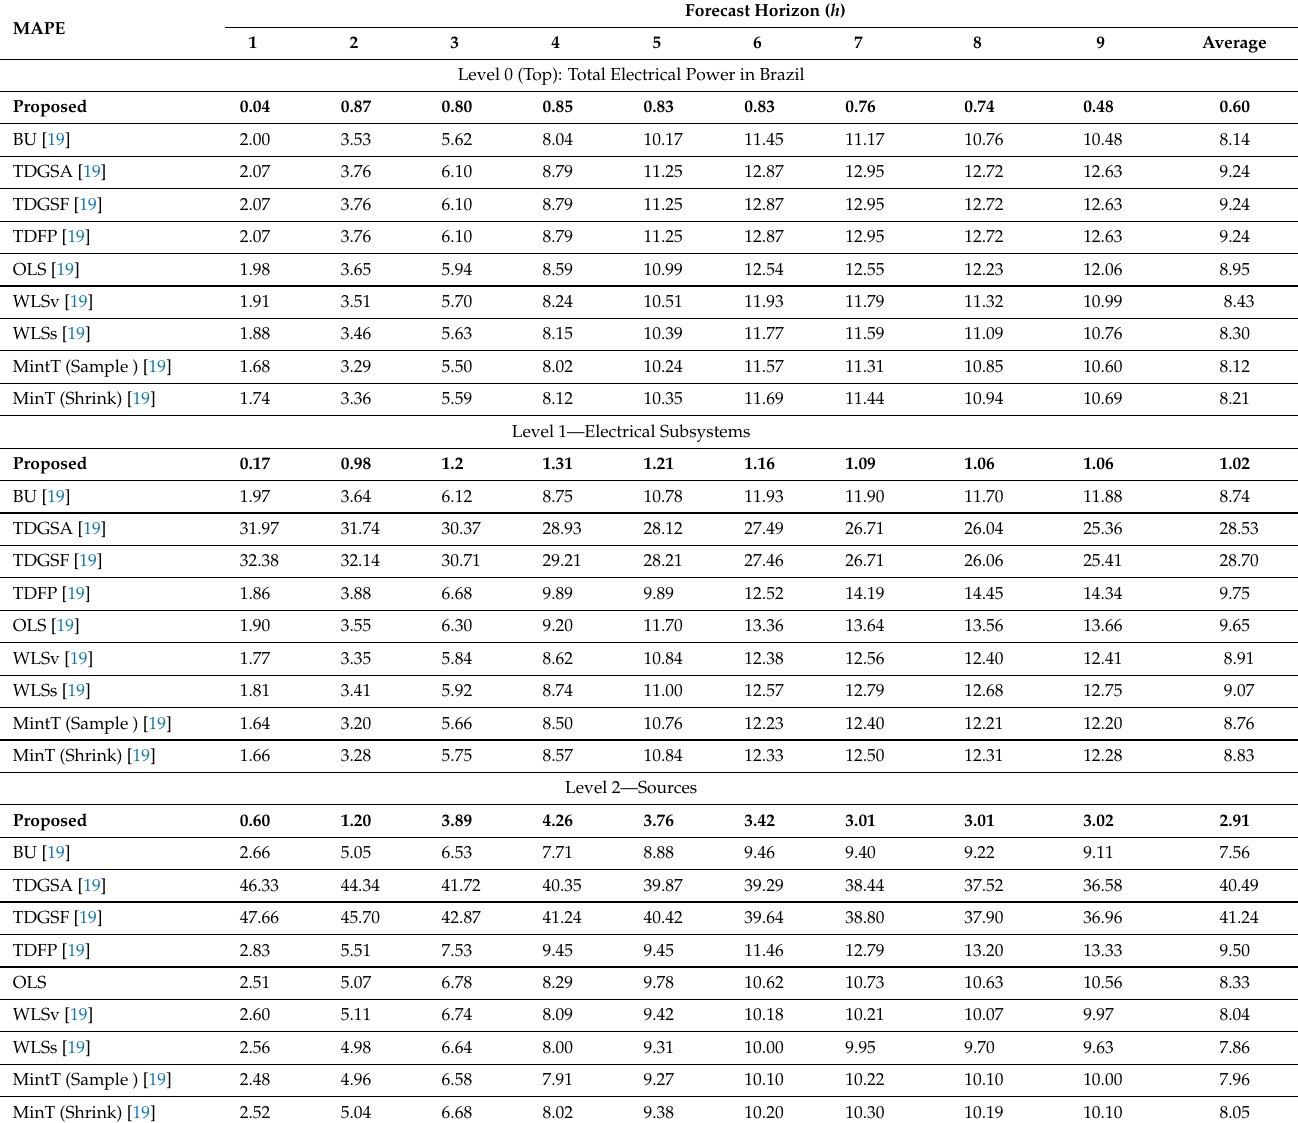
Table 3. Performance comparison based on the MAPE performance metric between the proposed approach and the reference approaches to solve the Brazilian power generation problem as reported in [19].